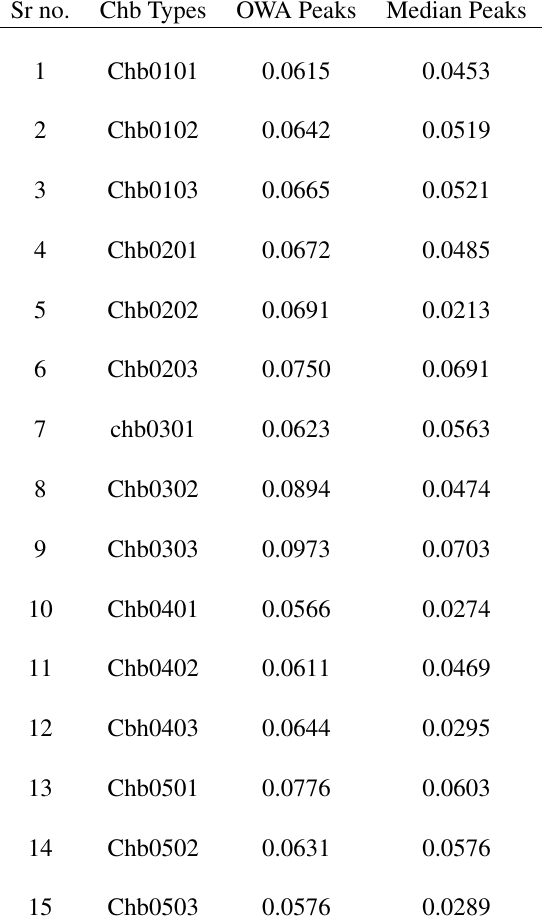
Table 3. Peaks Preservation of OWA